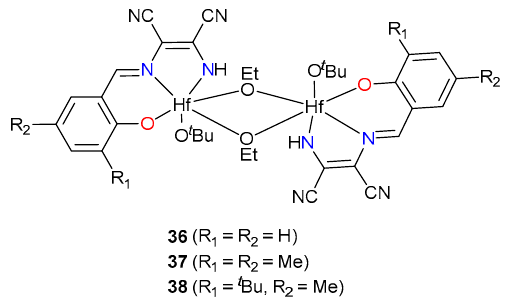
Figure 7. Cyano-containing bimetallic Hf complexes 36–38 [45].